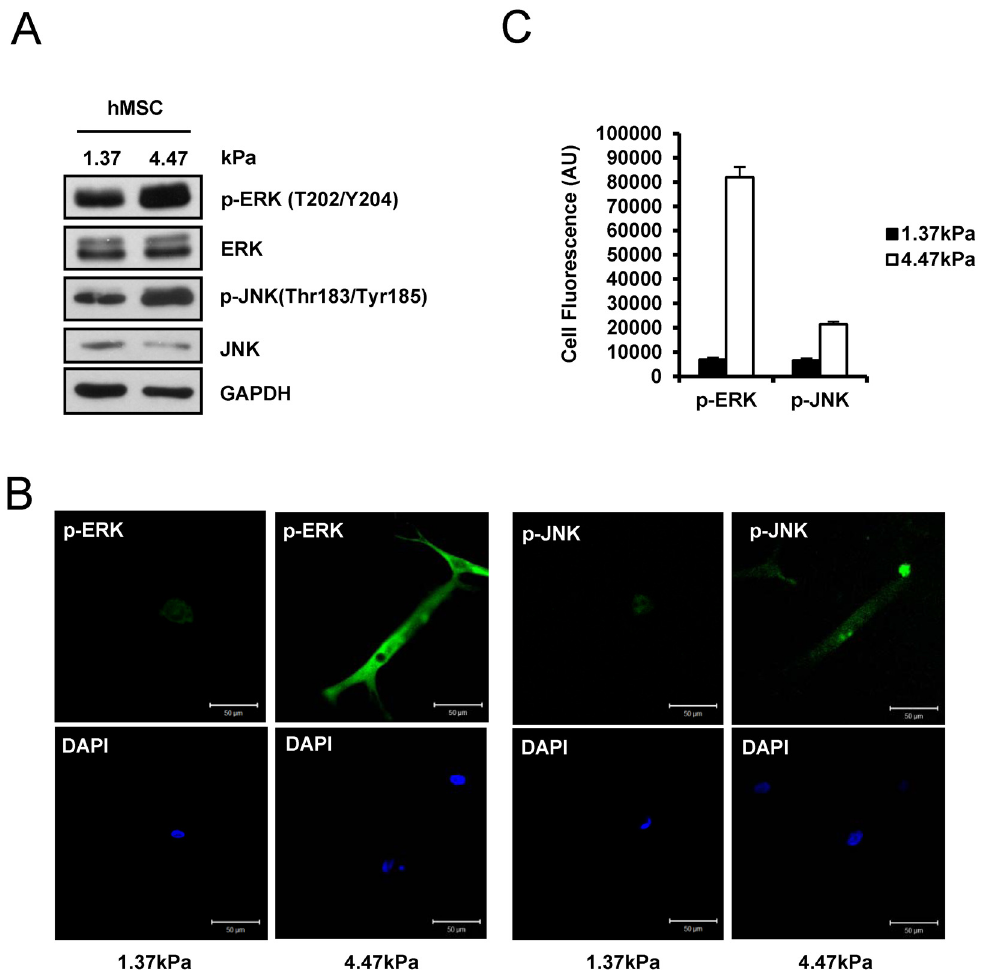
Fig 3. A stiff ECM activates the ERK and JNK signaling pathway. (A) hMSCs were plated on a 1.37 or 4.47 kPa hydrogel, and after 12 h, cell lysates were prepared and analyzed by immunoblotting. To assess the activity of ERK and JNK, phosphorylated ERK (p-ERK) and phosphorylated JNK (p-JNK) antibodies were used, respectively. As a control, total ERK and JNK protein was analyzed. The levels of phosphorylated ERK and JNK were increased in hMSCs cultured on the stiff matrix. GAPDH was used as a loading control. (B) Immunocytochemistry of p-ERK and p-JNK in hMSCs on a 1.37 or 4.47 kPa hydrogel. Cells in panel (A) were fixed and subjected to immunocytochemical staining with a p-ERK or p-JNK antibody. The signals for p-ERK or p-JNK were green fluorescence. DAPI was used for nuclear staining. (C) Fluorescence signals in panel (B) was quantified by image J software and corrected total cell fluorescence was calculated by fluorescence signal with elimination of background signal. AU is arbitrary